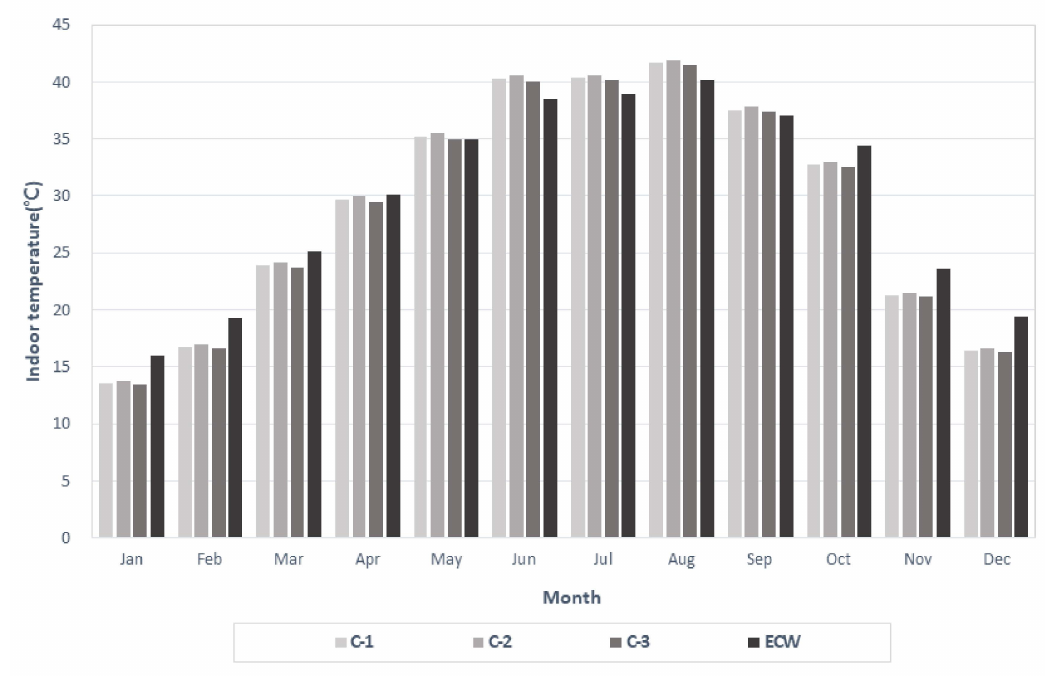
Figure 8. Indoor temperature by direction (Monthly)—East.